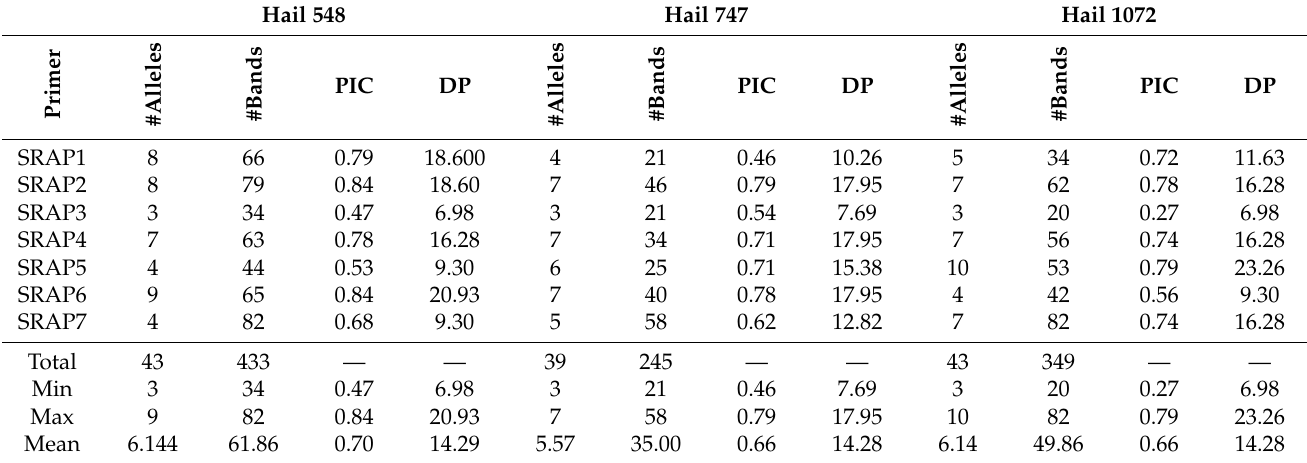
Table 4. Features of SRAP amplified products used for analysis of genetic diversity in Hail tomato landraces. Hail 548 Hail